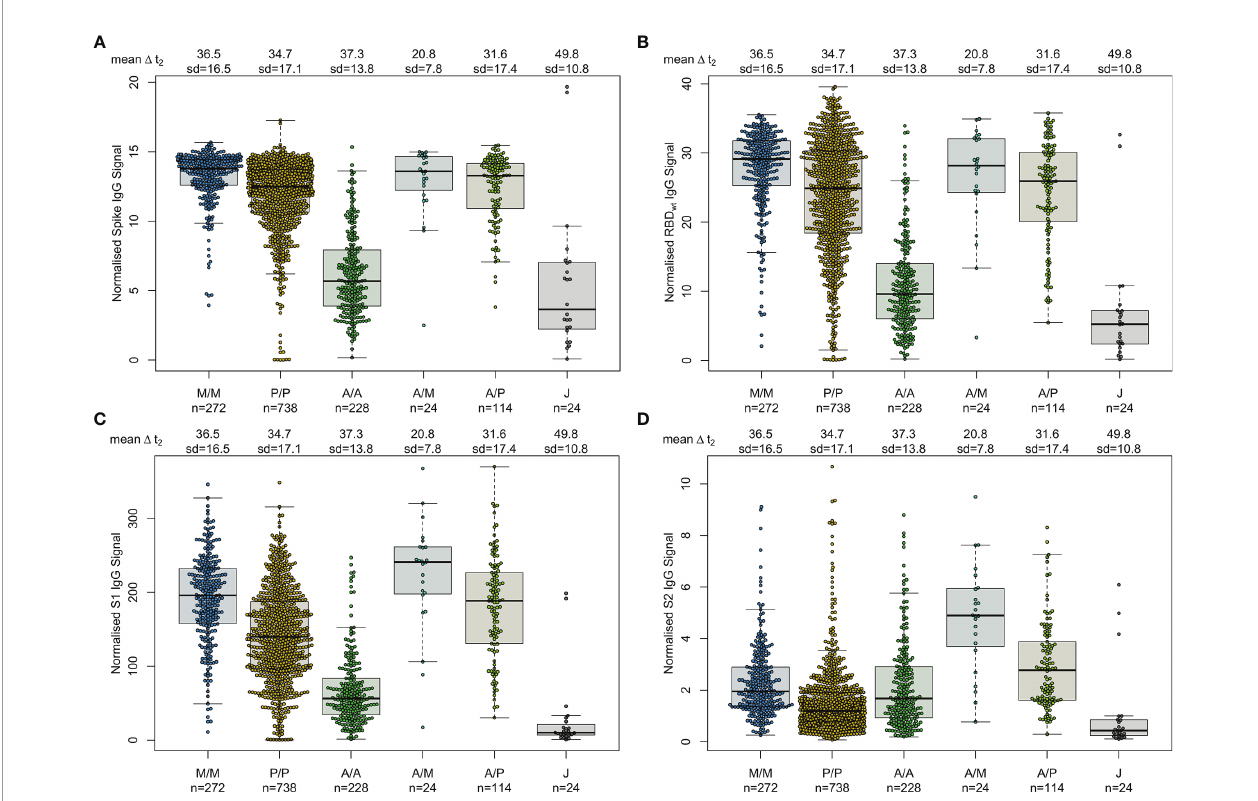
FIGURE 1 | Different SARS-CoV-2 vaccination schemes result in distinct humoral responses. IgG antibody titres against full-length Spike trimer (A) , receptor-binding domain (RBD) (B) , S1 domain (C) and S2 domain (D) were measured with MULTICOV-AB. Individuals received either homologous mRNA-1273 (M/M, blue, n = 272), BNT162b2 (P/P, orange, n = 738) or AZD1222 (A/A, green, n = 228), heterologous AZD1222-mRNA-1273 (A/M, light blue, n = 24), AZD1222-BNT162b2 (A/P, light green, n = 114), or a single dose of Ad26.CoV2.S (J, grey, n = 24). Raw MFI values were normalised against QC samples to generate signal ratios for each antigen. Data is shown as box and whisker plots overlaid with strip charts. Boxes represent medians, 25th and 75th percentiles and whiskers show the largest and smallest non-outlier values based on 1.5 IQR calculation. Time between sampling and full vaccination is displayed as mean and SD for each group. Number of samples per vaccination scheme are stated